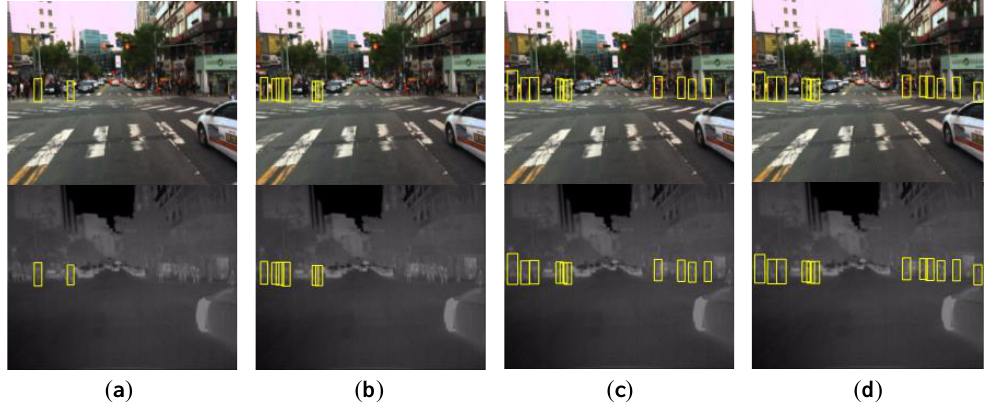
Figure 8. Qualitative examples for the ablation study. Detection results of the detector ( a ) trained only on CVC-14 dataset, ( b ) adapted initially on the generated intermediate images, ( c ) fine-tuned iteratively from CVC-14 to KAIST dataset without using intermediate images and ( d ) adapted from CVC-14 to KAIST dataset using our whole framework.